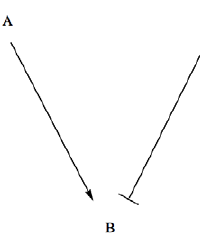
Figure 3. Double graph associated with the input strings (13) for the GeneticNetworks software package.